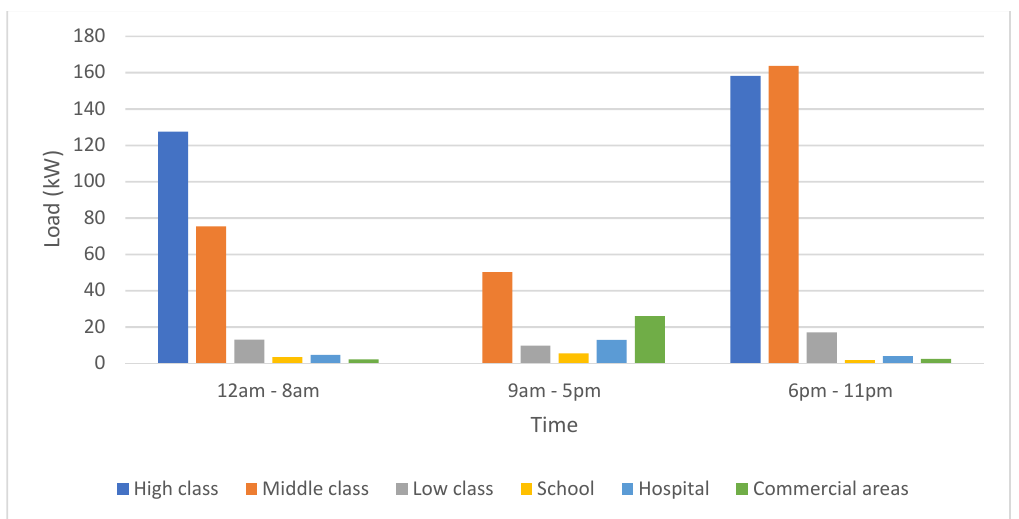
Figure 4. Community pro fi le.